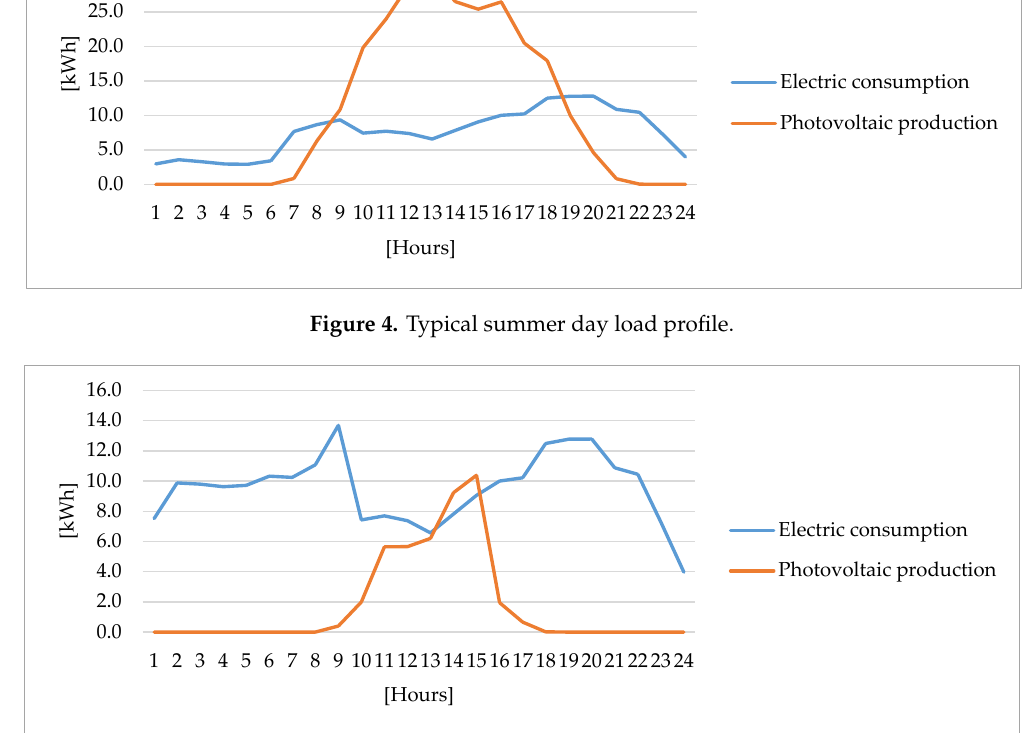
Figure 5. Typical winter day load profile.